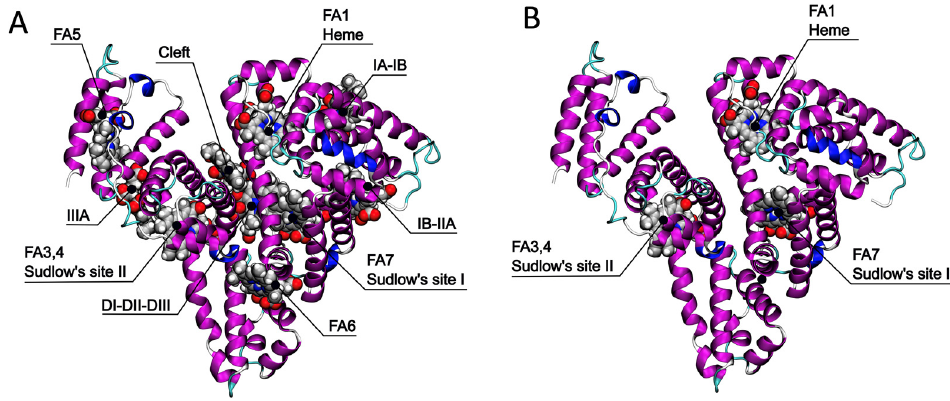
Figure 2. ( A ) The ten most probable Ce6 binding pockets in HSA, identified by docking; ( B ) the three most probable Ce6 binding sites in HSA identified by molecular dynamics simulations.